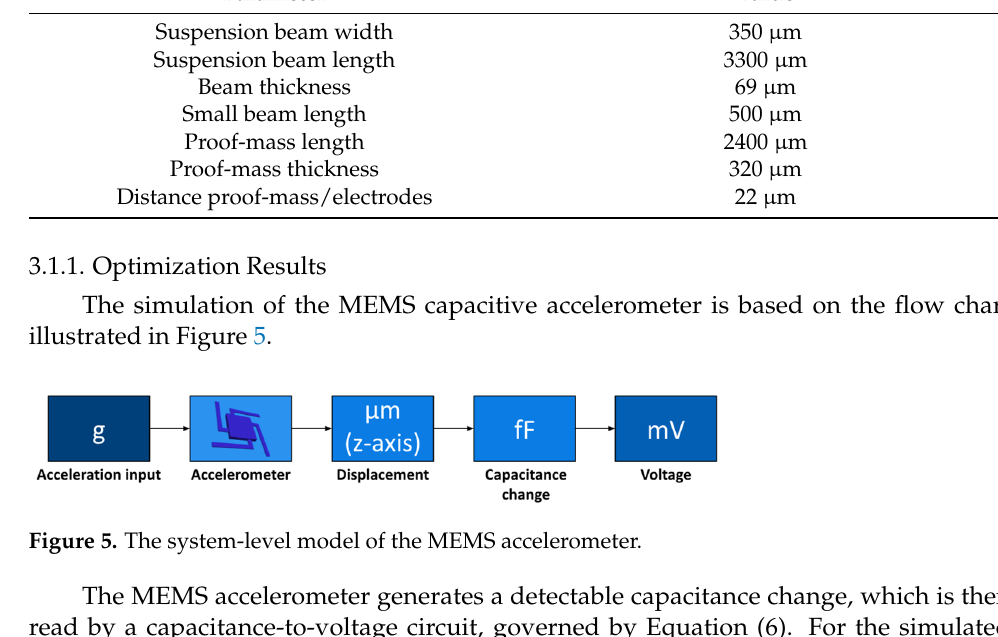
Table 1. Initial geometric parameters of the MEMS accelerometer.